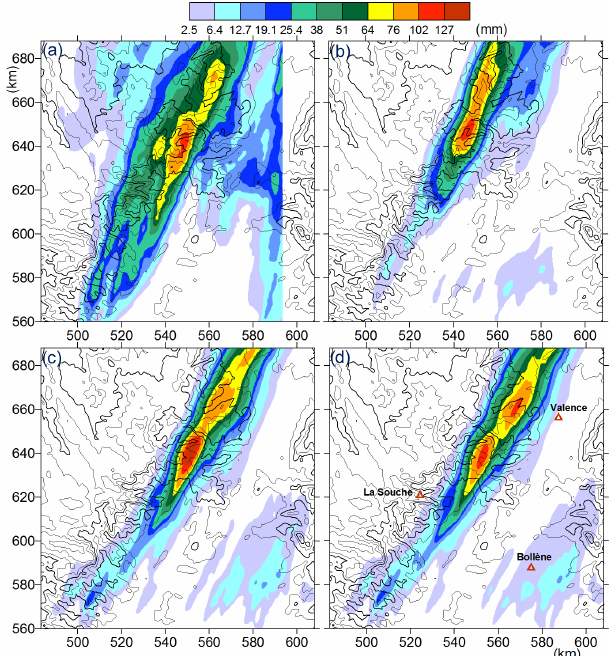
Figure 4. Observed and simulated rain accumulation for 26 Septem- ber 2012, at 11:00UTC. Panel (a) corresponds to the observations (i.e. KED analysis), (b) to the simulation using HymRef, (c) to the simulation Remote and (d) to the simulation HymLow.